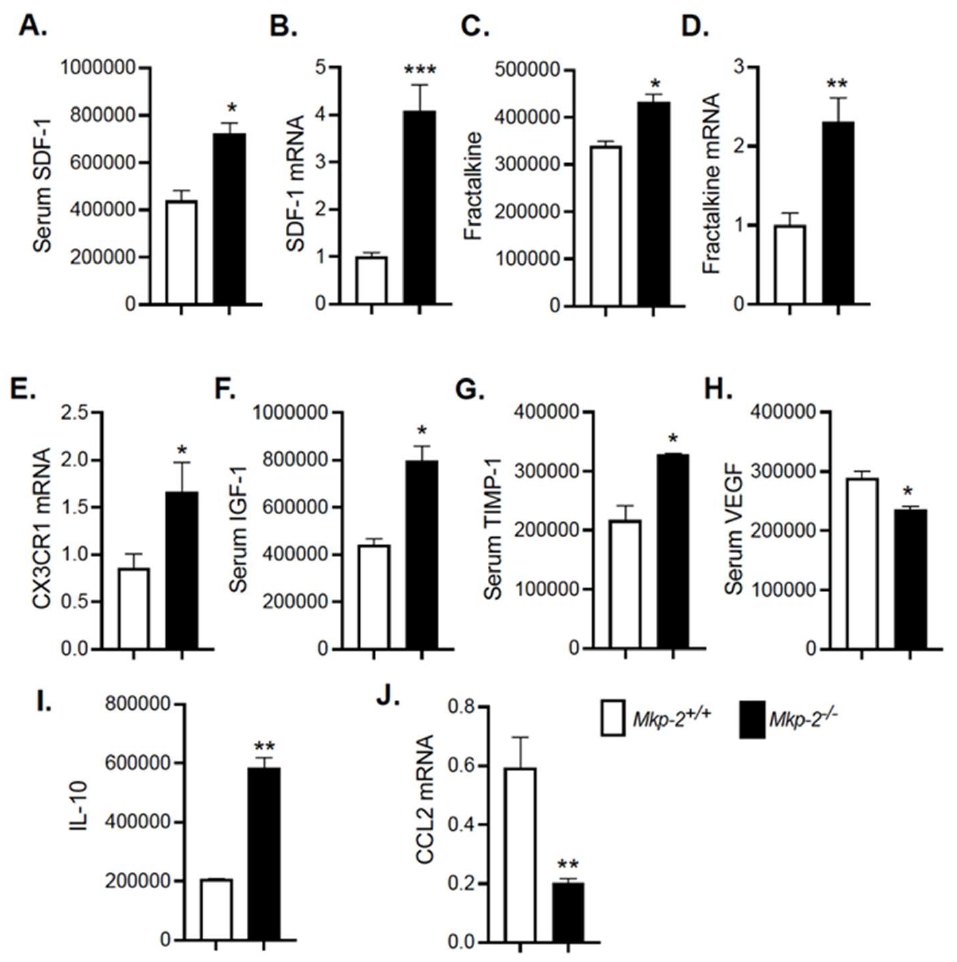
Figure 8. Modulation of Cytokines/Chemokines and Growth factor Secretion in HFD-fed Male MKP-2-Deficient mice. Serum protein levels of secreted cytokines from HFD-fed Mkp-2 +/+ and Mkp-2 −/− mice for 24 weeks (N = 4/genotype). ( A ) SDF-1, ( B ) hepatic SDF-1 mRNA, ( C ) fractalkine, ( D ) hepatic fractalkine mRNA, and ( E ) its receptor CX3CR1, ( F ) IGF-1, ( G ) TIMP-1, ( H ) VEGF, IL-10 ( I ), and ( J ) CCL-2. Results represent the mean ± SEM; * p < 0.05, ** p < 0.01, *** p < 0.0001, as determined by Student’s t -test. Open bars, Mkp-2 +/+ mice; closed bars, Mkp-2 −/− mice.